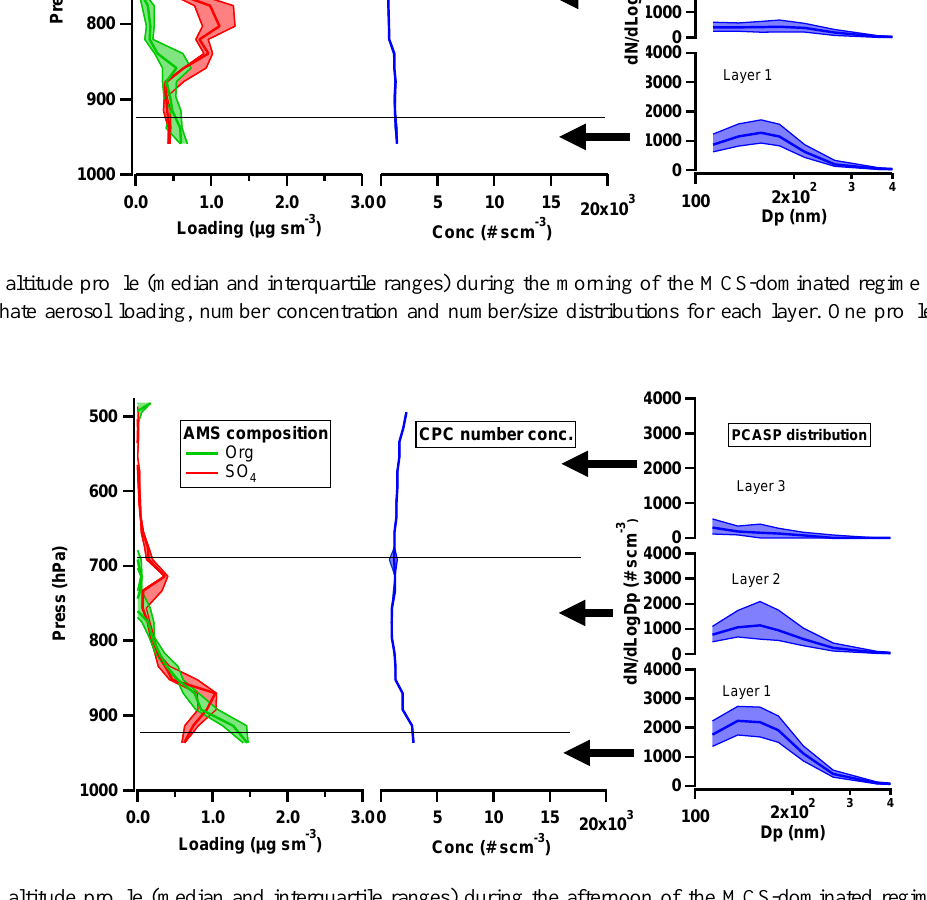
Fig. 11. Average altitude profile (median and interquartile ranges) during the afternoon of the MCS-dominated regime over East Sabah of organic and sulphate aerosol loading, number concentration and number size distributions for each layer. One profile on 16 July 2008,